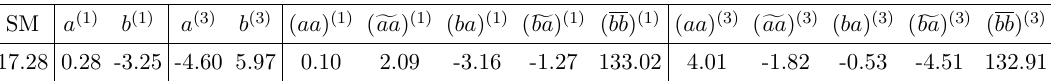
Table 4 . Contributions of flavor coefficients to ∆ m s in units of ps − 1 . The reference scale is set to µ 0 = 2 . 4 TeV ; the cutoff scale is fixed to Λ = 1 TeV. The contributions are rounded to two decimal